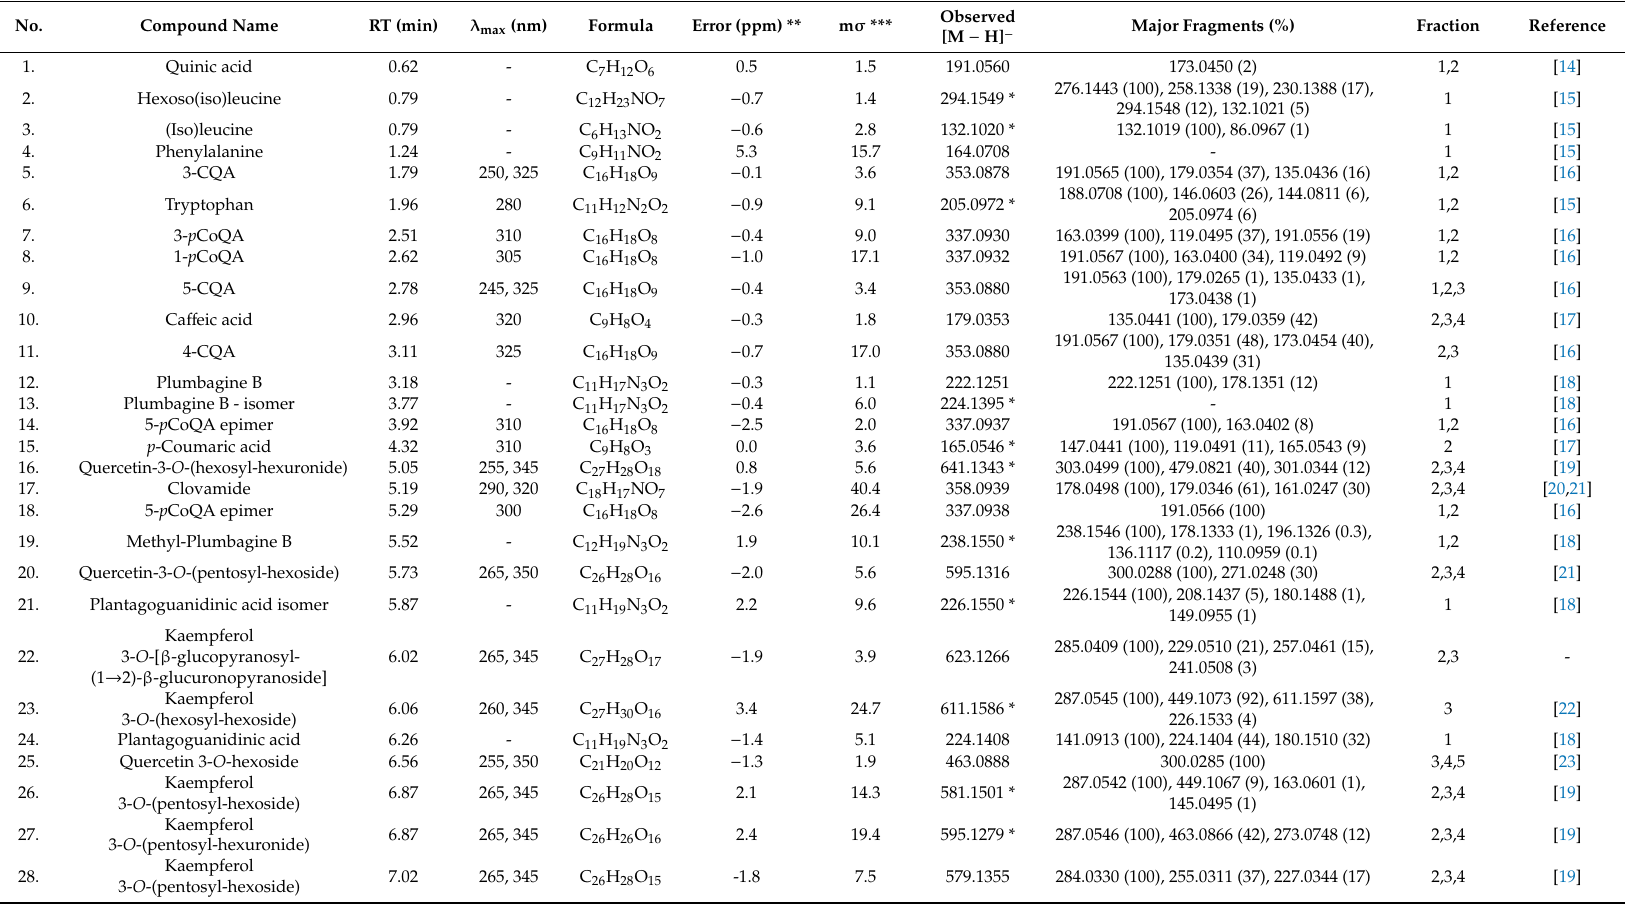
Table 1. Compounds identified in the Z. elegans methanolic extract and the obtained fractions using UHPLC-QTOF-MS /